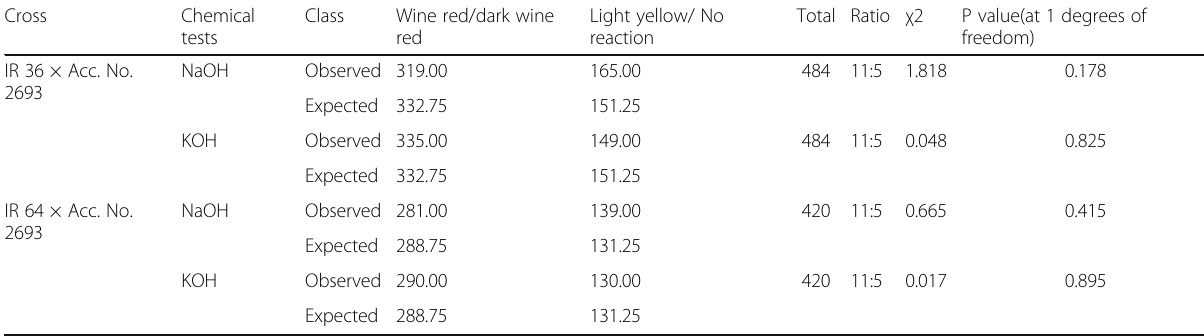
Table 3 Aleurone layer color segregation in F 2 progenies of the crosses IR 36 × Acc.No. 2693 and IR 64 × Acc. No. 2693 for NaOH and KOH